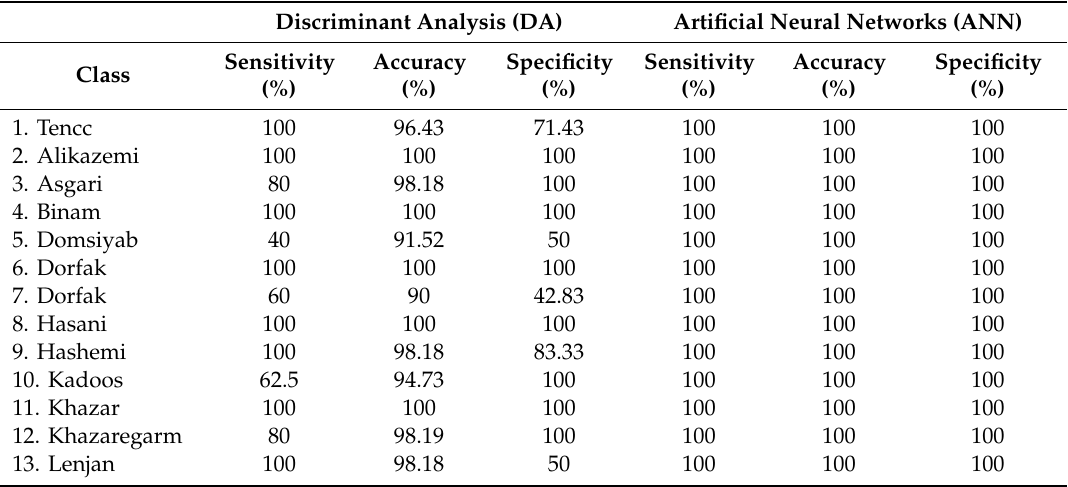
Table 5. Performance criteria for the two classifiers in the classification of paddy varieties.